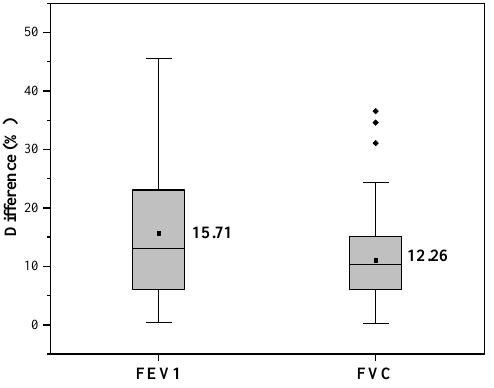
Figure 8. Box plot of error percentages of conventional machine learning. We used a single-structured deep learning algorithm for pulmonary function predic- tion. The CO 2 sequences are processed by a one-dimensional convolutional neural net- work and the results are evaluated using relevant evaluation metrics.